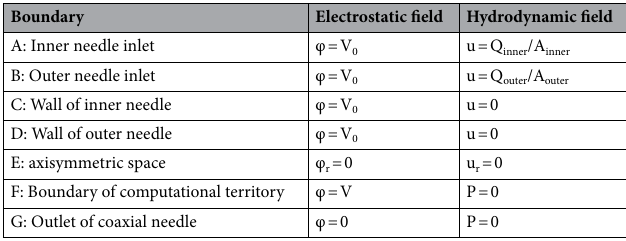
Table 2. The boundary conditions of the phase field method.